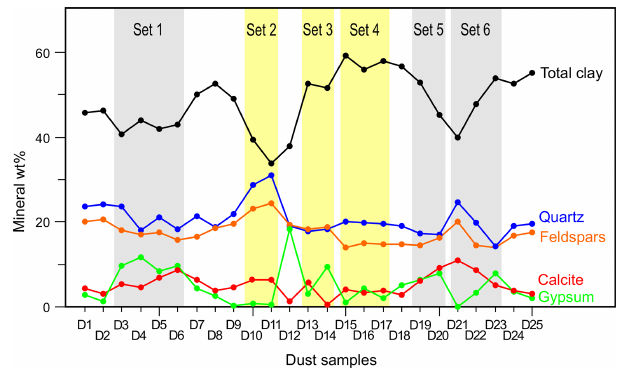
Figure 4. Time-series variation in the major mineral contents of Asian dust. Sample collection dates are provided in Table 1. Dust sample sets 1, 5, and 6 comprise serial samples collected during individual dust events. Dust sample sets 2–4 comprise samples col- lected at different sites during individual dust events.